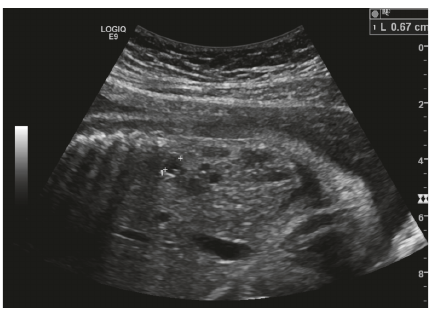
Figure 3: Multicystic dysplastic right kidney at 27 + 6